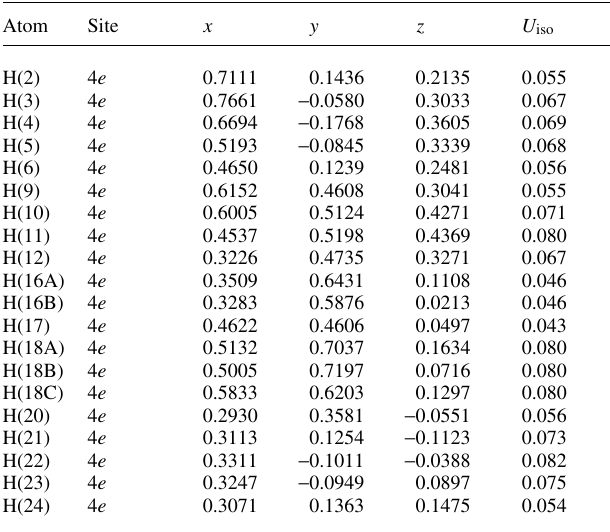
Table 2. Atomic coordinates and displacement parameters (in Å 2 )